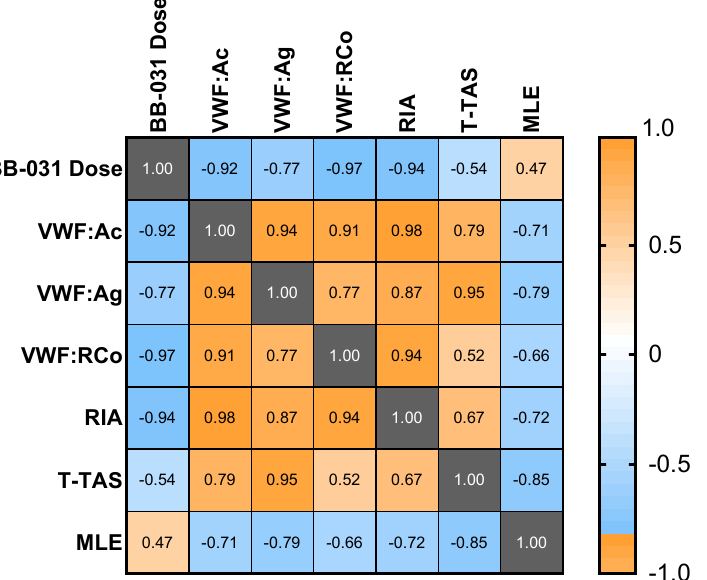
Figure 7. Correlation matrix of assay parameters. Pearson correlation coefficients ( ρ ) calculated among paired samples and visualized in a correlation matrix. RIA: Ristocetin Impedance Aggregometry; MLE: microfluidic lytic efficacy.